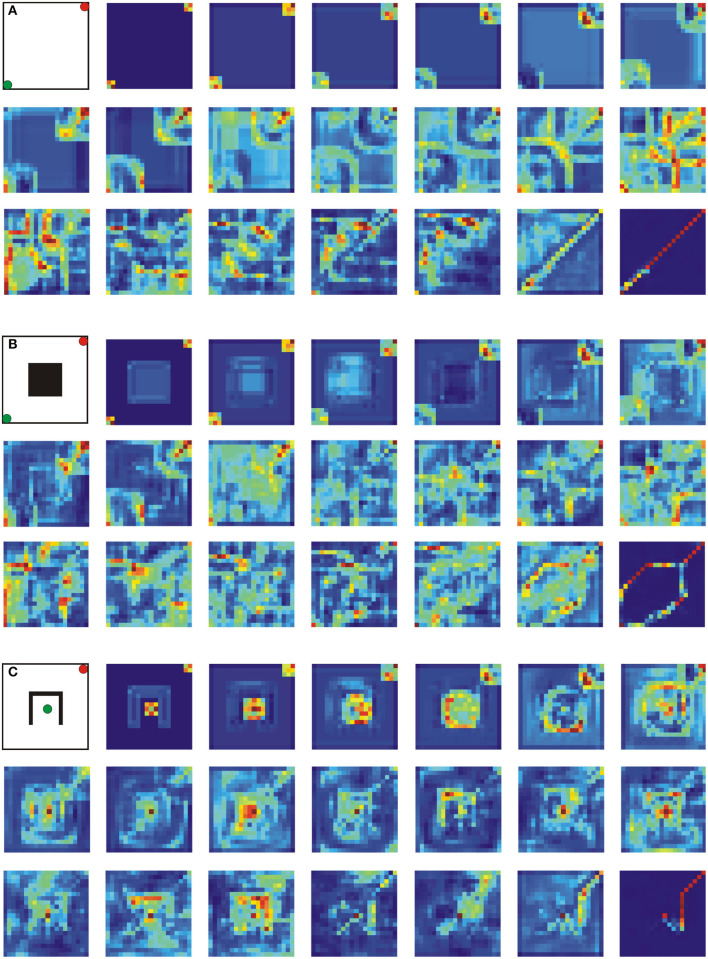
Analysis of the network's internal activity on three different environments of size 20 × 20. A network architecture with 21 layers was used in all three cases. (A) Environment without obstacle, (B) environment with a rectangular obstacle in the center, and (C) environment with an inverted u-shape obstacle in the center. Green and red dots correspond to start- and end-points, respectively. Each activity map shows the contribution of all 64 feature maps (sum over the feature maps) for layers 1–19, and 21. Blue and dark colors correspond to high and low activity, respectively.